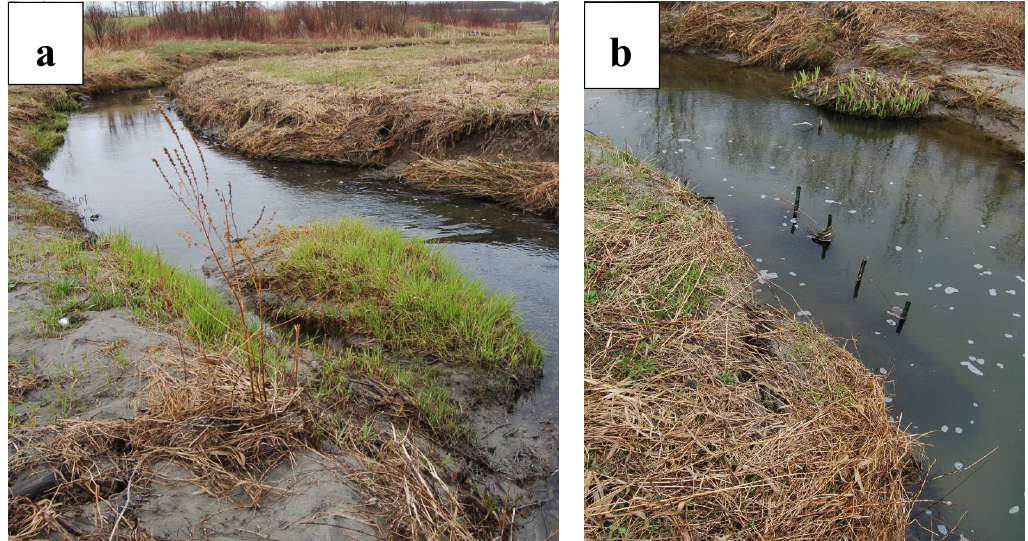
Figure 3. M4 sampling reach, meander bend restrained by the City of Ottawa rail, facing downstream: ( a ) Inner bank was overtopped during the previous high freshet flow, to an erosion pathway through the inner bank; ( b ) Vertical metal stakes used for bank stabilization. Pictures were taken by the authors on 30 April 2014.